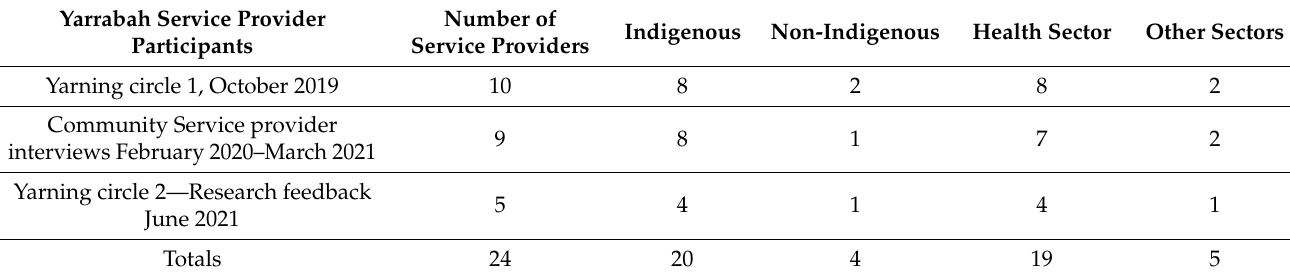
Table 2. Service provider